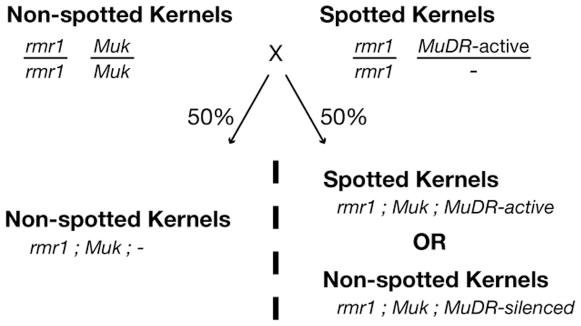
Crossing scheme used to assess role of RMR1 in establishing Muk-based silencing of MuDR.